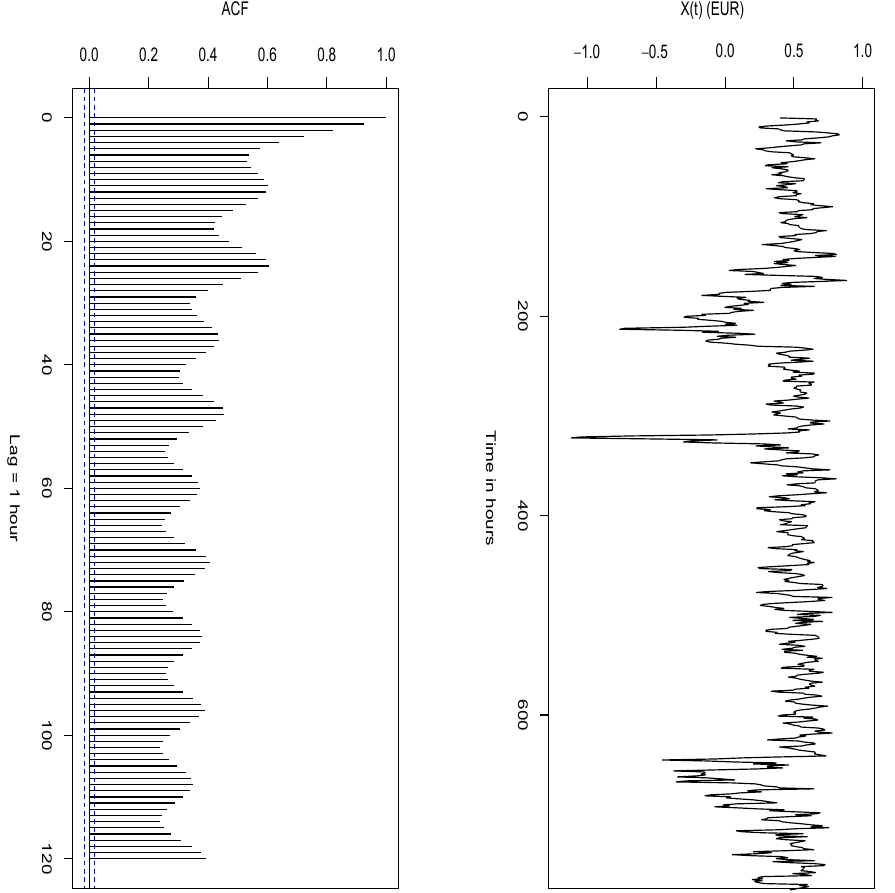
Figure 3. Top panel: the time series of X ( t ) reported for January 2016. Bottom panel: the estimated ACF. The parameters obtained and reported below aim to maximize the Akaike information criterion (AIC) and log-likelihood function. AIC is the main decision criterion for most of the calibration processes in this